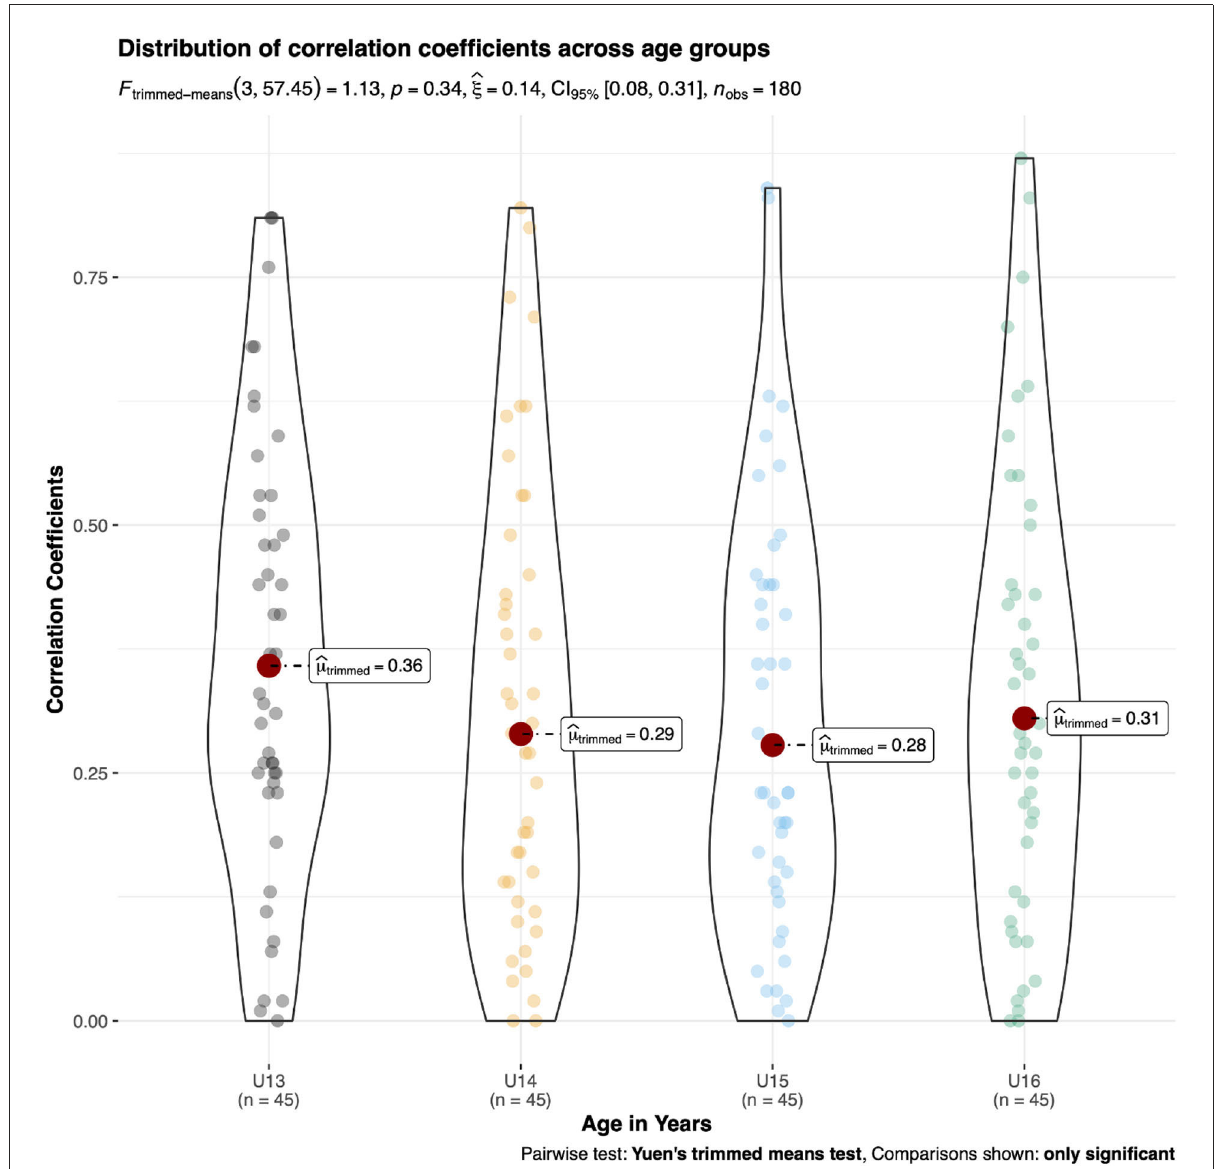
FIGURE6 Post-hoc tests on trimmed means of different age categories of absolute inter-item correlation coefficients in young female kayakers.